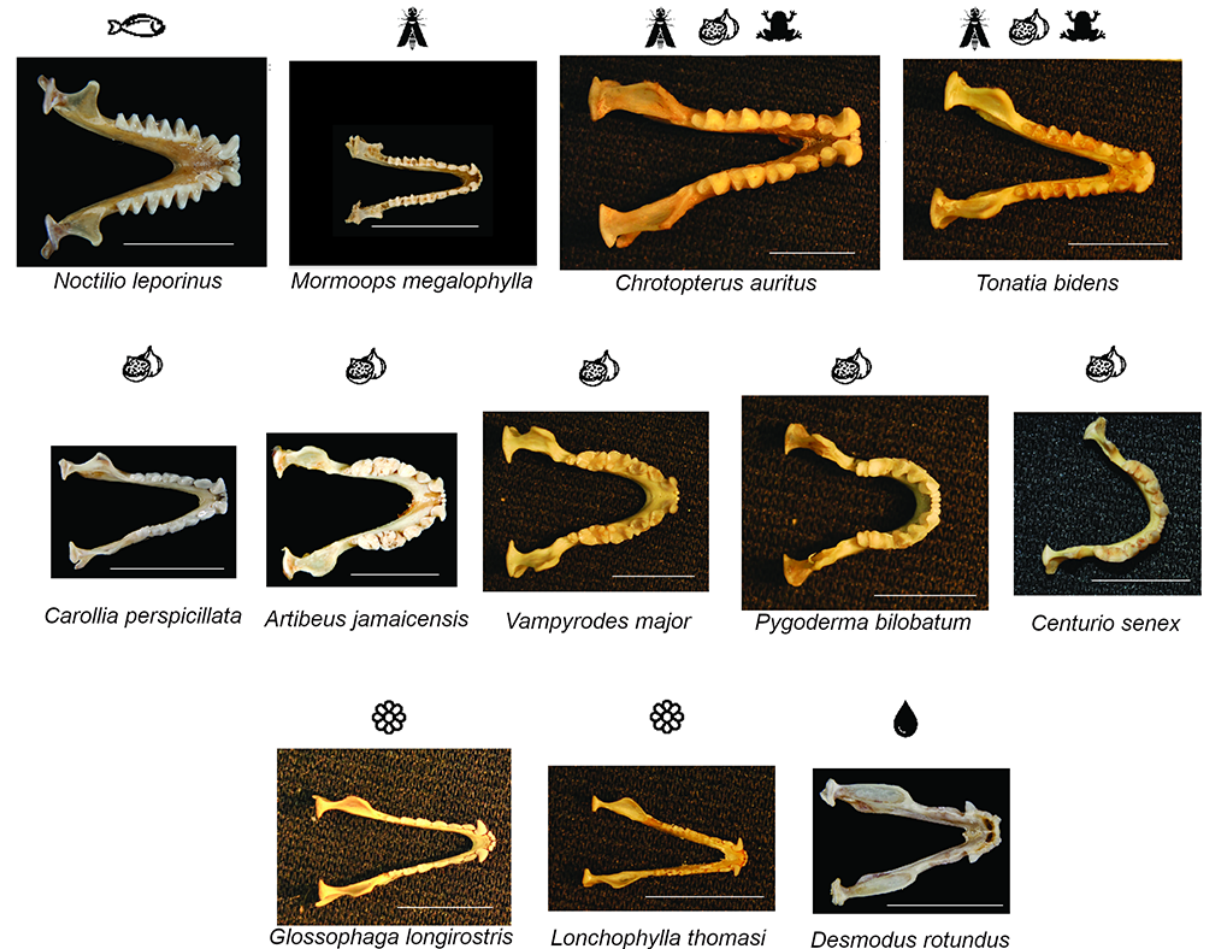
Figure 4 – Jaw and dental diversity of Noctilionoid bats. Members of the group occupy every possible dietary niche found in bats. In line with this, jaw size and shape as well as tooth shape, size and proportion are highly variable in Noctilionoid bats. In fact, the jaw and tooth types shown represent most of the breadth of the diversity found in both bat superfamilies. Diet is indicated with a pictogram. Scale: 10